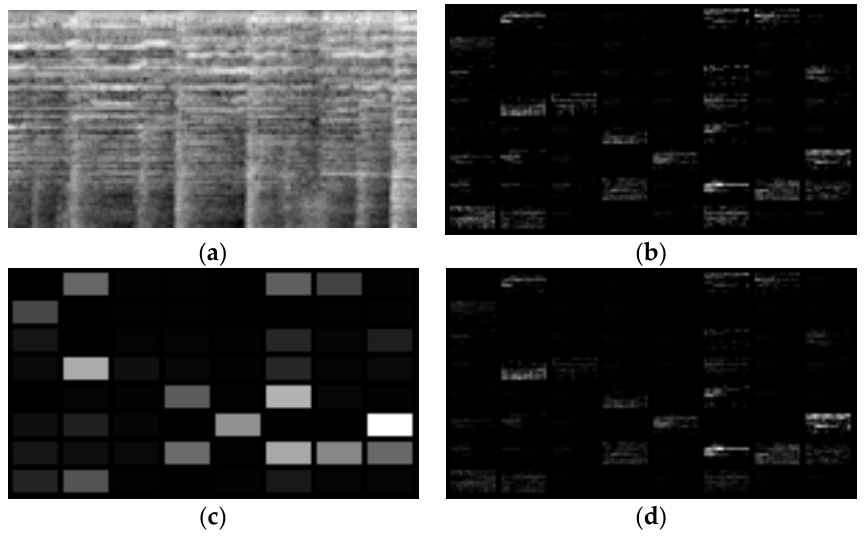
Figure 10. Comparison between the input and the output feature maps of a scaled dot-product attention module. ( a ) An input image from the log-mel spectrogram of the music “you are”, ( b ) the input feature map, ( c ) the attentions or the weights of the corresponding channel of the output feature map ( d ).